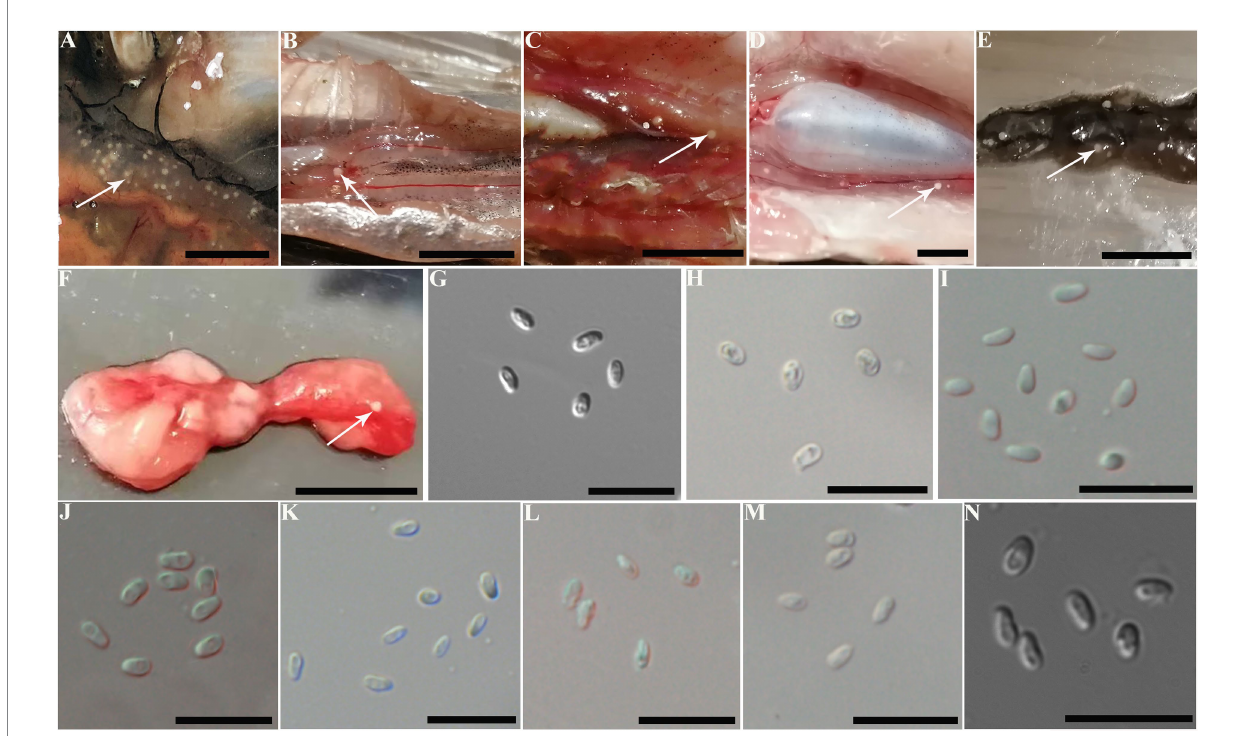
FIGURE 2 Macroscopical observation and light microscopy of Pseudokabatana alburnus isolated from the ovary of different fishes from different geographical locations. (A–F) A gallery of cysts (arrow) of P. alburnus located in the ovary of different fish, demonstrating the similar morphology of cysts. (A) Squaliobarbus curriculus. (B) Hemiculter leucisculus. (C) Pseudolaubuca engraulis. (D) Cultrichthys erythropterus. (E) Toxabramis swinhonis. (F) Elopichthys bambusa. Scale bar = 10 mm. (G–N) A gallery of P. alburnus spores from various fish species, demonstrating the similar spore morphology. (G) Spores isolated from S. curriculus from Poyang Lake. (H) Spores isolated from H. leucisculus from Luoma Lake. (I) Spores isolated from P. engraulis from Luoma Lake. (J) Spores isolated from C. erythropterus from Luoma Lake. (K) Spores isolated from T. swinhonis from Luoma Lake. (L) Spores isolated from H. leucisculus from Weishan Lake. (M) Spores isolated from C. erythropterus from Weishan Lake. (N) Spores isolated from E. bambusa from Gehu Lake. Scale bar = 10 μ m.